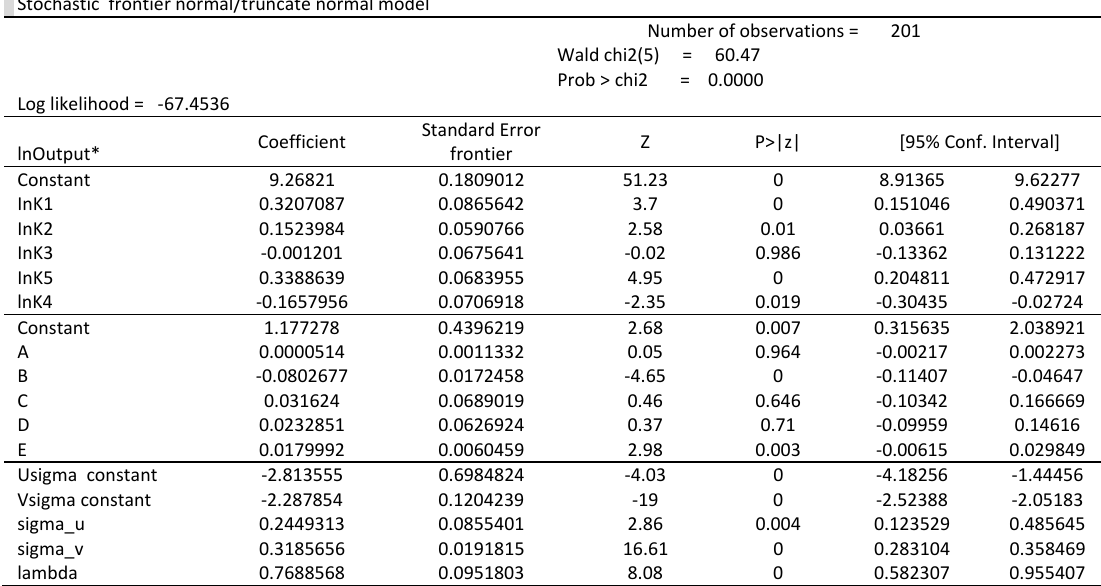
Table 3: Results of the determinants of technical inefficiency Stochastic frontier normal/truncate normal model